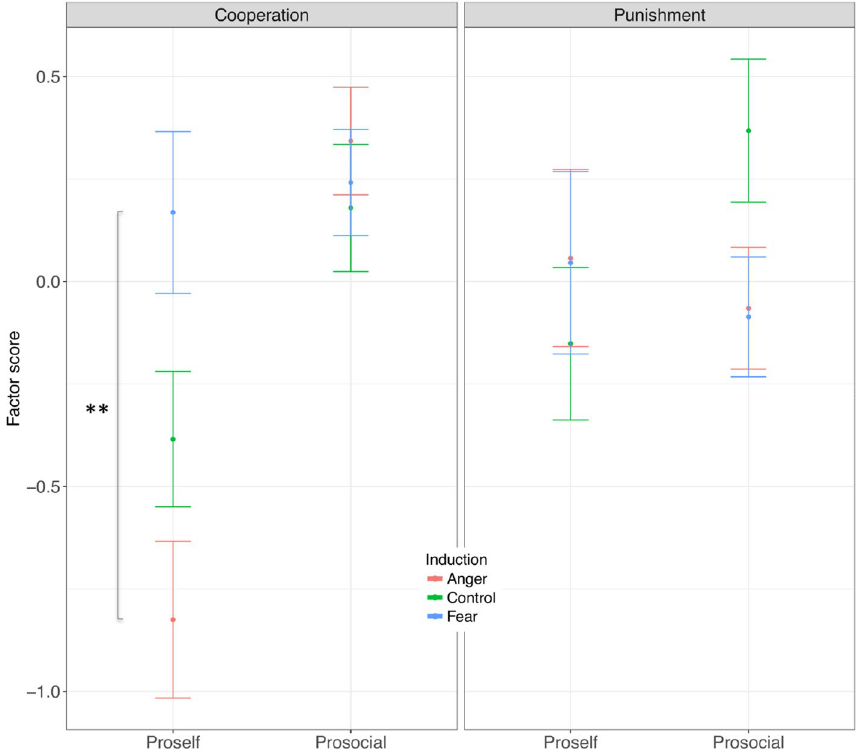
Figure 4. Top: latent measures of cooperation (left) and punishment (right) as a function of induced Fear or Anger, relative to participants in a Control induction. Error bars represent 95th confidence intervals. ***p < 0.001, **p < 0.01, *p <